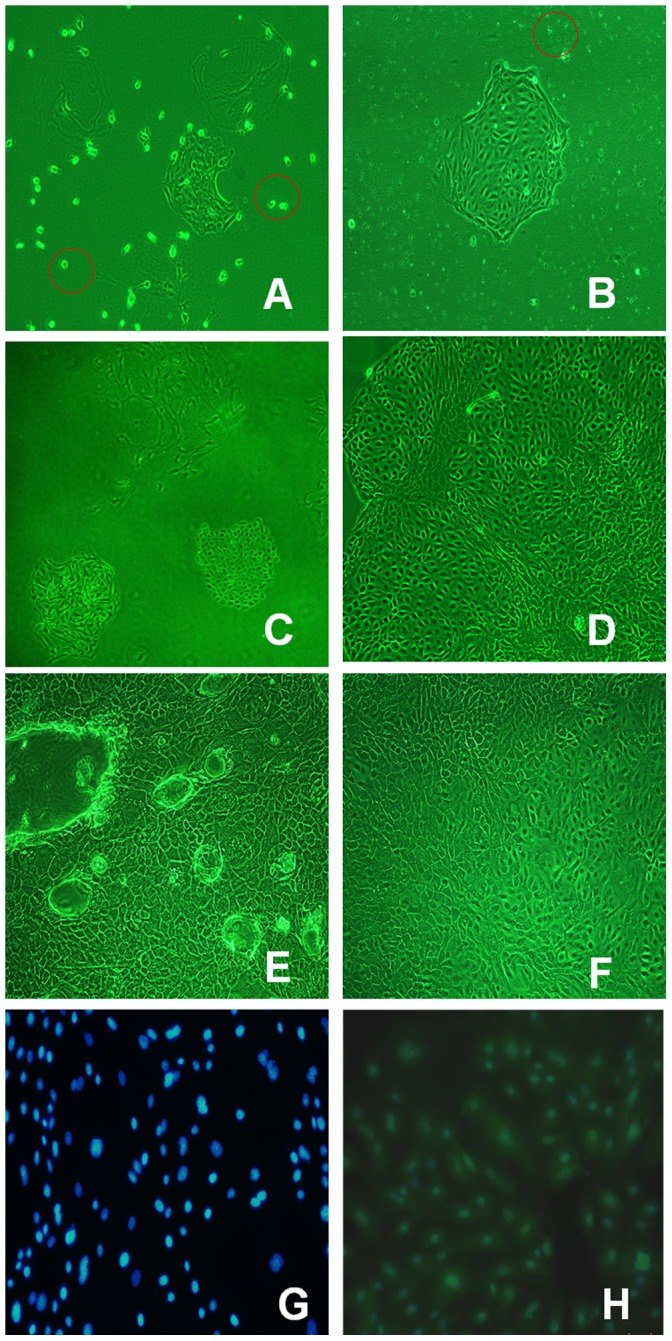
Primary bovine mammary epithelial Cell isolation and identification.Photomicrographs of the process obtained bovine epithelial cells and morphology of epithelial cells. (A–F). In panel A, single cells and small epithelioid islands of cells were apparent, spread upon the substrate after 24 h later, single cells with the granular appearance of macrophages were present. which noted by red color (100×); In panel B, a large epithelioid islands generated from a single cell after 3 days (100×). Occasional macrophages were present,which made up<5% of all attached cells. In panel C, many large epithelioid islands generated after 9 days, and phagocytes disappeared (100×); In panel D, areas of large cells arose within islands after two weeks in culture (100×); In panel E, the emulsion droplets secreted to the outside of the cells (100×); In panel F, the purified epithelial cells obtained over three passages (100×). Immunofluorescence analysis of bovine mammary cells (G-H). In panel G, first antibody (anti-cytokeratin 8) replaced by PBS as negative control, which pictured by fluorescence microscope. The cell nucleus were blue (DAPI) (100×).; In panel H, fluorescent image of cells incubated with anti-cytokeratin 8 monoclonal antibody, pictured by fluorescence (100×).